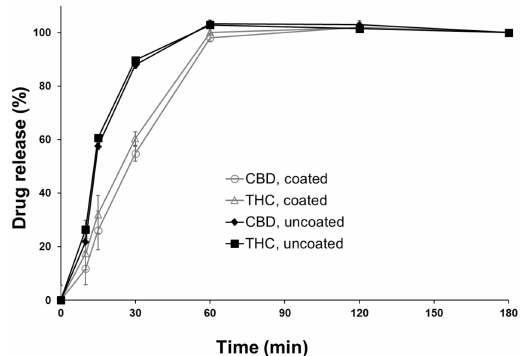
Figure 4. Drug release of CBD and THC of coated and uncoated DEEP with 7 imprinted layers. Data are presented as mean ± SD ( n = 3).